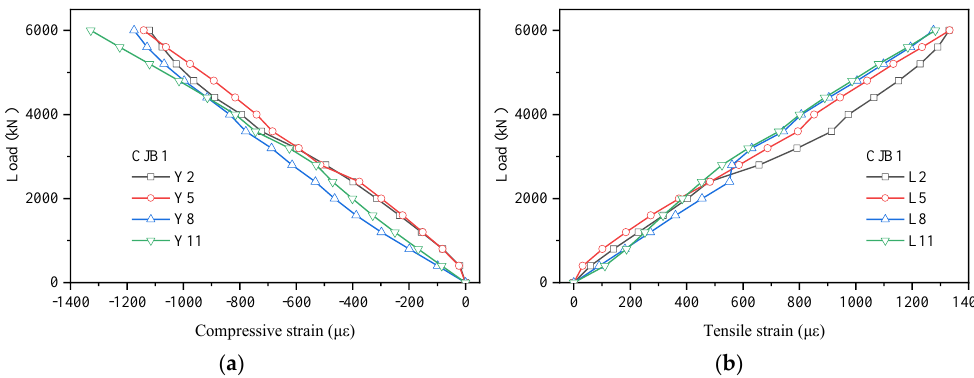
Figure 13. Load–strain curves of the steel web. ( a ) the compressive steel web of CJB1; ( b ) the tensile steel web of CJB1.